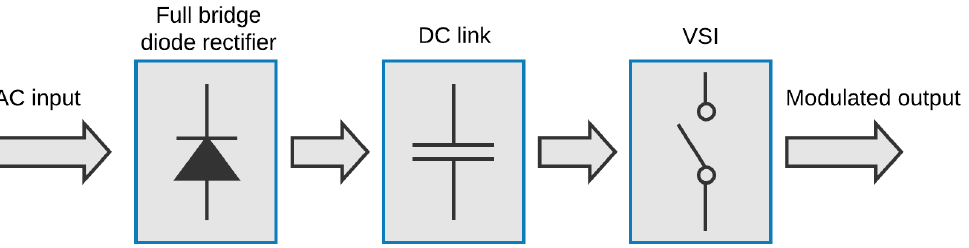
Figure 2. Diagram of a voltage